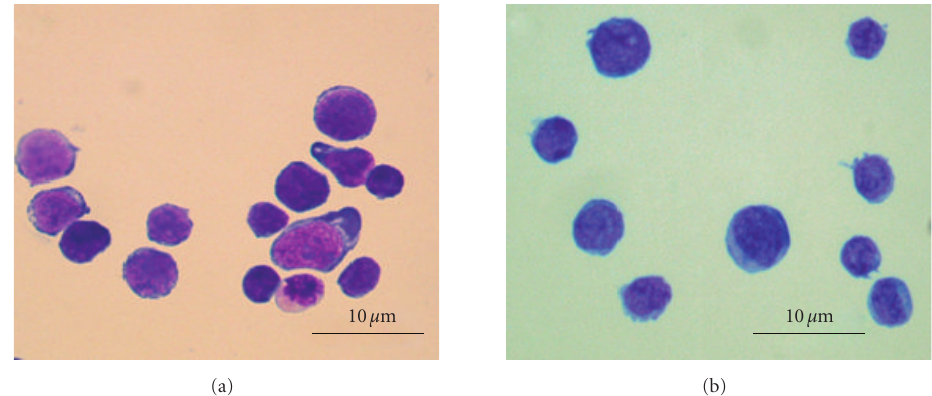
Figure 3: Morphology of (a) haematopoietic progenitor cells displaying a heterogeneous morphology and (b) the more purified LSK showing a more homogeneous morphology (light microscopy ×